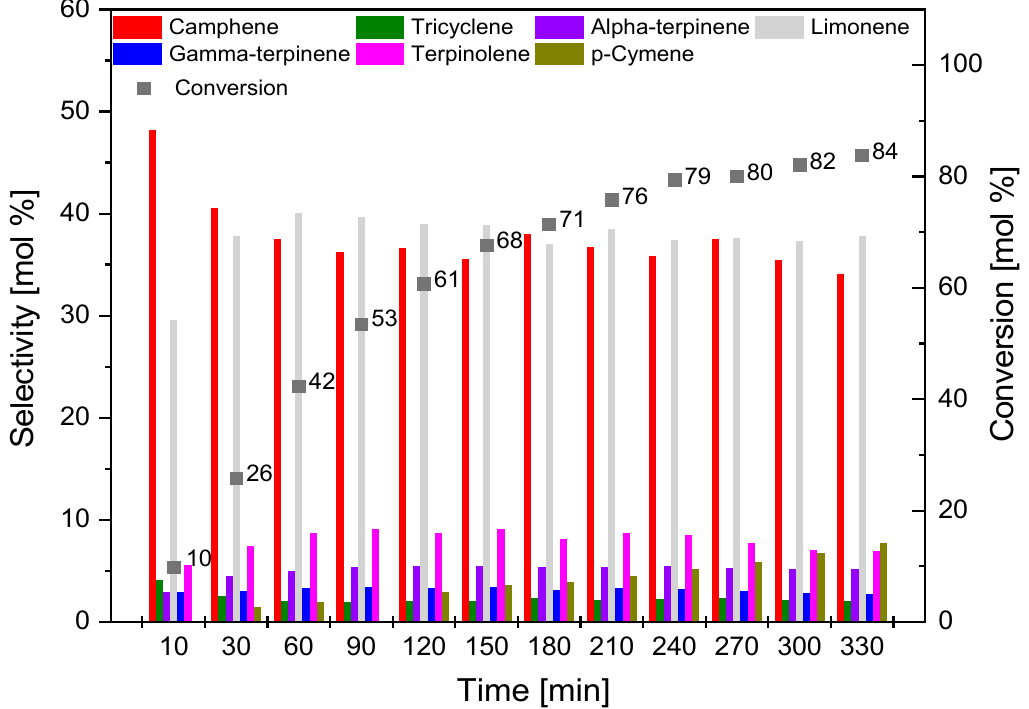
Figure 14. Influence of time on the selectivity of the main products and the conversion of organic raw material (alpha-pinene) for C_AC sample.